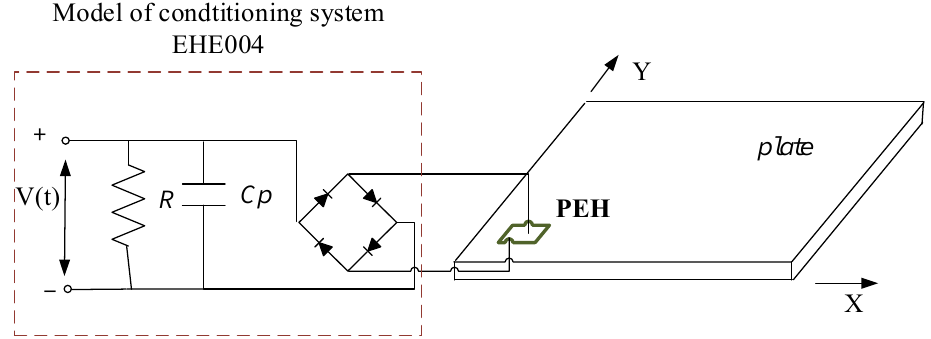
Figure 7. The piezo-harvester connected to a standard AC-DC conversion circuit: full-wave rectifier, a smoothing capacitor, resistive load.